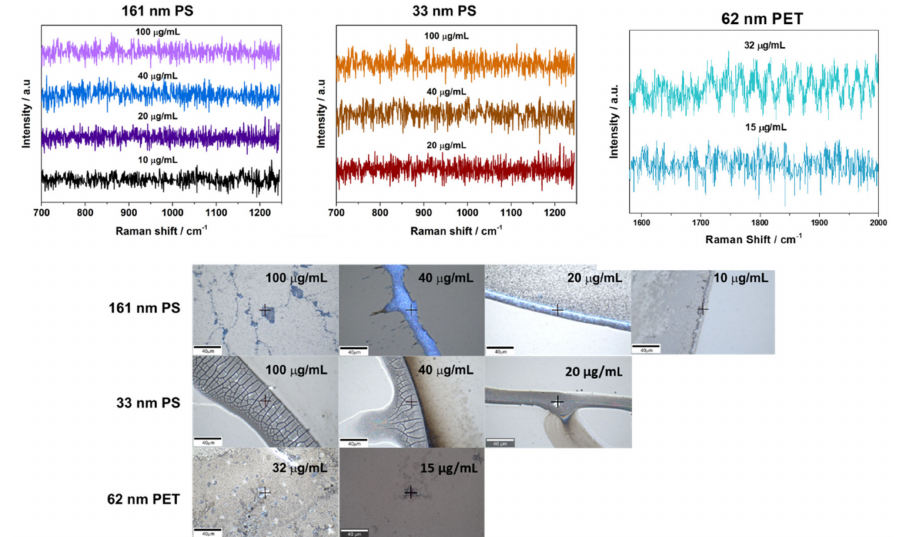
Figure A9. Representative Raman spectra obtained for 161 nm PS particles on plain glass and 33 nm PS nanoparticles on plain glass. Spectra obtained are shown above images of the region of interest (ROI) the measurement was obtained from. The images are labelled with the relevant sample information. Scale for all is 40 µ m. Laser power, scan speeds, and number of averaged accumulations for the samples can be viewed in Table A1. Additionally, representative Raman spectrum obtained for PET nanoparticles on plain glass is shown. Scale is 40 µ m.